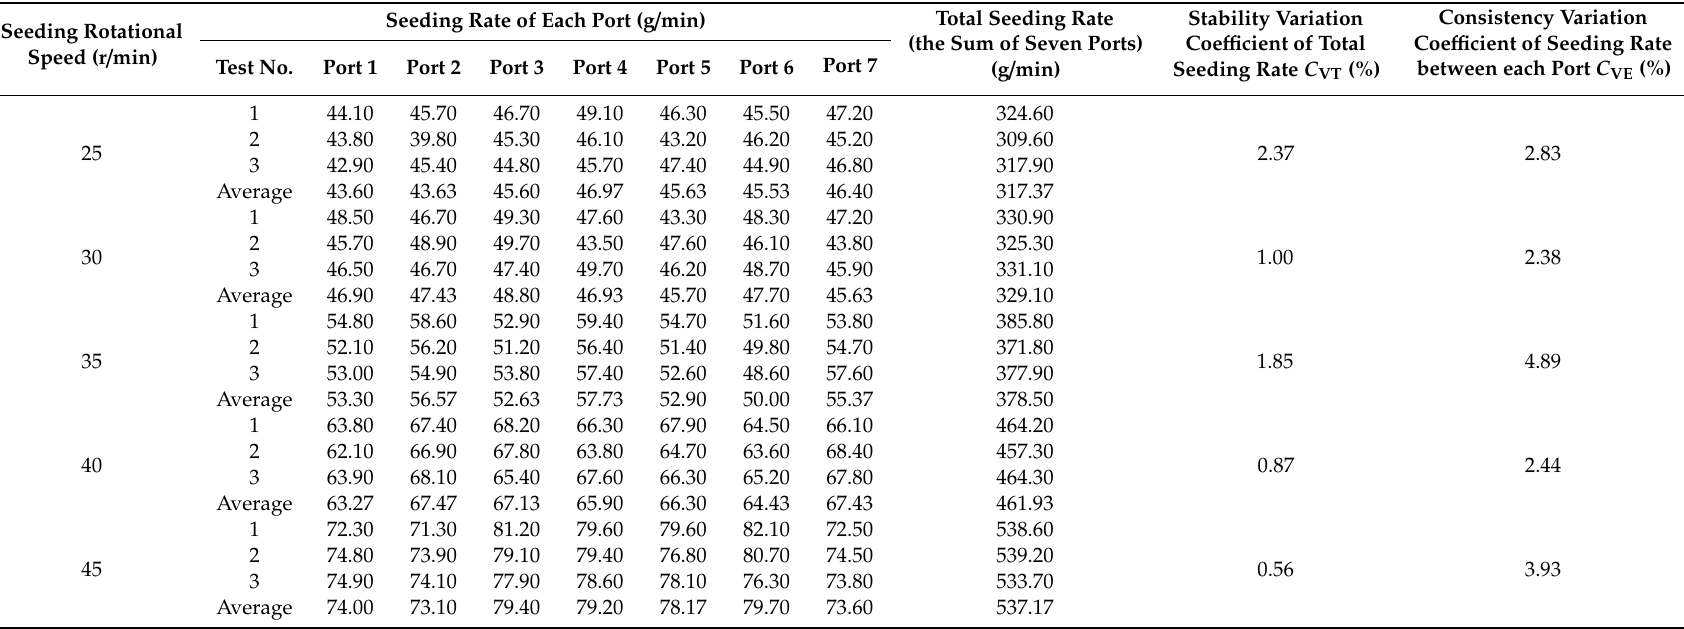
Table 3. E ff ect of rotational speed on seed metering